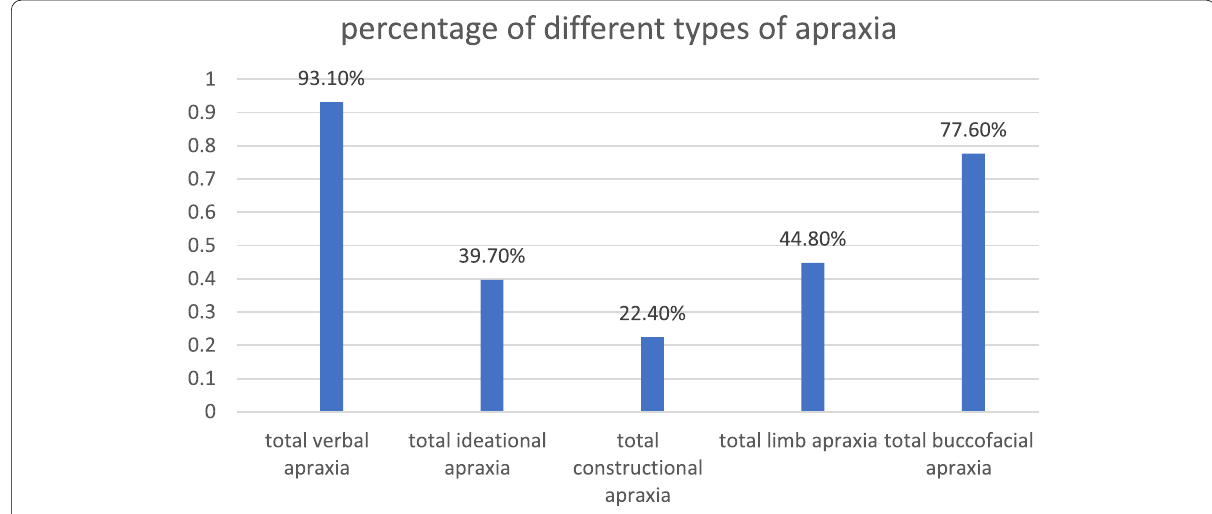
Fig. 3 Distribution of different types of apraxia among cases. 93.1% of patients had verbal apraxia, 39.7% of patients had ideational apraxia, 22.4% had constructional apraxia, 44.8% had limb apraxia, and 77.6% had buccofacial